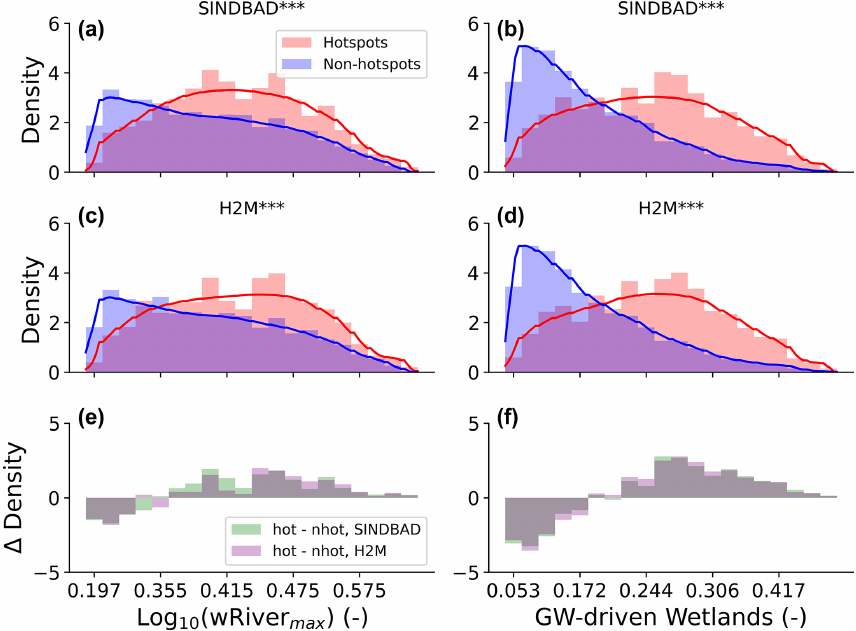
Figure 7. Comparison of probability density distributions of the log-transformed maximum river water storage (a, c, e) and wetland frac- tion (b, d, f) between the error hotspot pixels and non-hotspot pixels. Panels (a) – (d) are the distributions of each model; panels (e) and (f) show the difference in the bar heights between the hotspots and non-hotspots (positive means occurrences are larger in error hotspots). The probability density curves were estimated using the Gaussian kernel and Scott’s rule of thumb to determine the bandwidth of the kernel. Asterisks ( ∗ ) beside the model names show the significance of the difference in the distributions between the error hotspots and non-hotspots using the Kolmogorov–Smirnov two-sample test; all results show the significant difference in the distributions ( ∗∗∗ ; p value < 0.001). Note that the x axis is normalized using the maximum and minimum of variables so that the range becomes 0 to 1 and comparisons can be made across variables. The river water storage (wRiver max ) was calculated using the Total Runoff Integrating Pathways (TRIP) river routing model (Oki and Sud, 1999) with the input of runoff from SINDBAD. The maximum wRiver of a pixel (wRiver max ) during the entire period (April 2002–June 2017) was used with log transformation to use the skewed distribution of (wRiver max ) for comparison. The fraction of groundwater-driven (GW-driven) wetlands was provided by Tootchi et al.